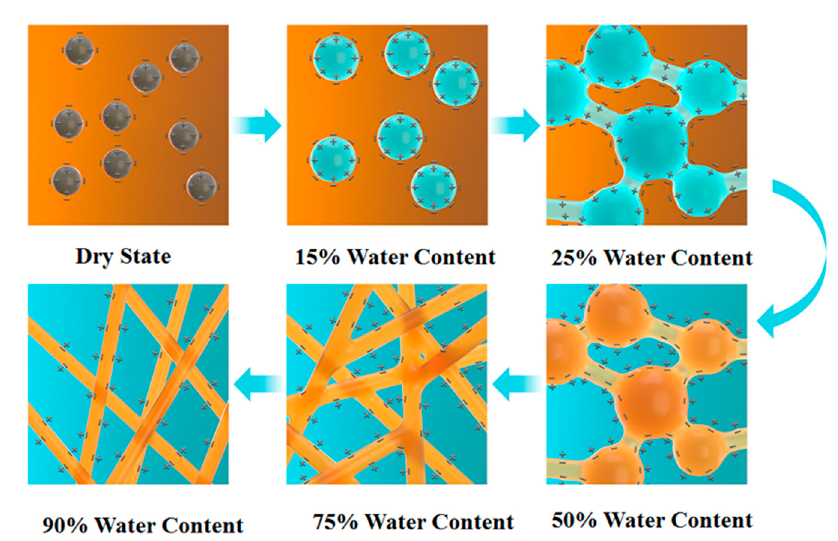
Figure 11. Changes in the phase state in the membrane with water content.